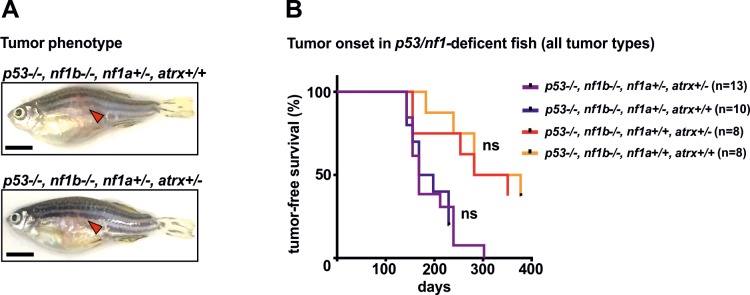
Addition of frameshift-mutations in atrx to the p53/nf1-deficient background induces specific changes in tumor biology.(A) The morphologic features of p53/nf1/atrx- and p53/nf1-deficient tumors were indistinguishable by visual inspection. (B) When all tumor types were considered, tumor onset was not significantly altered upon heterozygous loss of atrx; a representative tumor watch experiment using line 1 is shown; the tumor watch has been reproduced in lines 1 and 2 with similar results; ns = not significant.